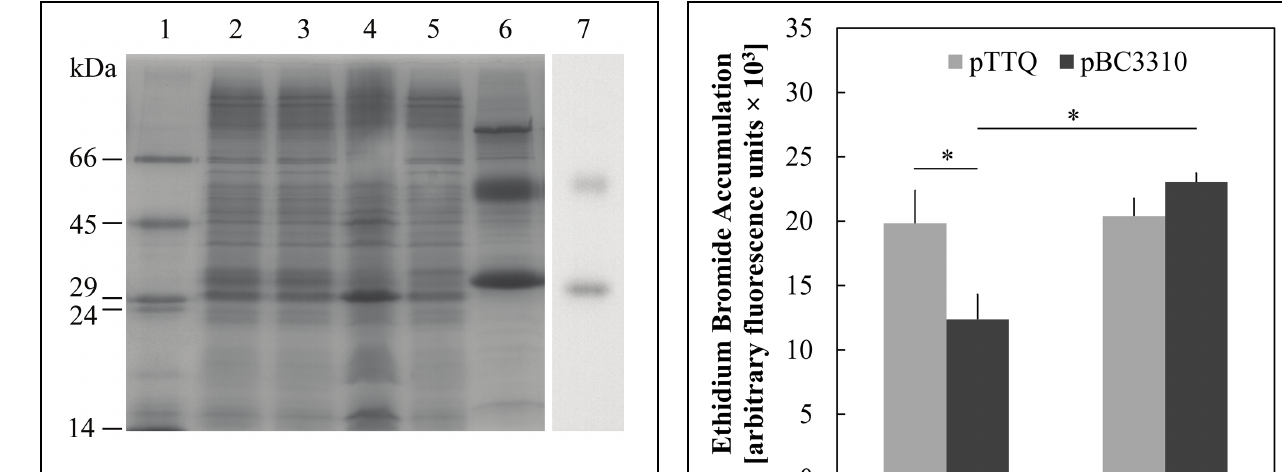
FIGURE 2 | Purification of BC3310-RGSHis 6 . BC3310 was expressed with RGS(His) 6 -tag in E. coli and inner and outer membranes were separated. BC3310-RGSHis 6 was solubilized with DDM and purified by immobilized metal affinity chromatography (IMAC). The SDS-PAGE was loaded as follows and stained with Coomassie Blue: (1) molecular weight marker; (2) inner membrane fraction; (3) solubilized protein; (4) unsolubilized protein; (5) flow-through after IMAC binding; (6) eluted protein. (7) Western blot detection of eluted BC3310 protein after affinity chromatography using an antibody to the RGSHis 6 epitope.